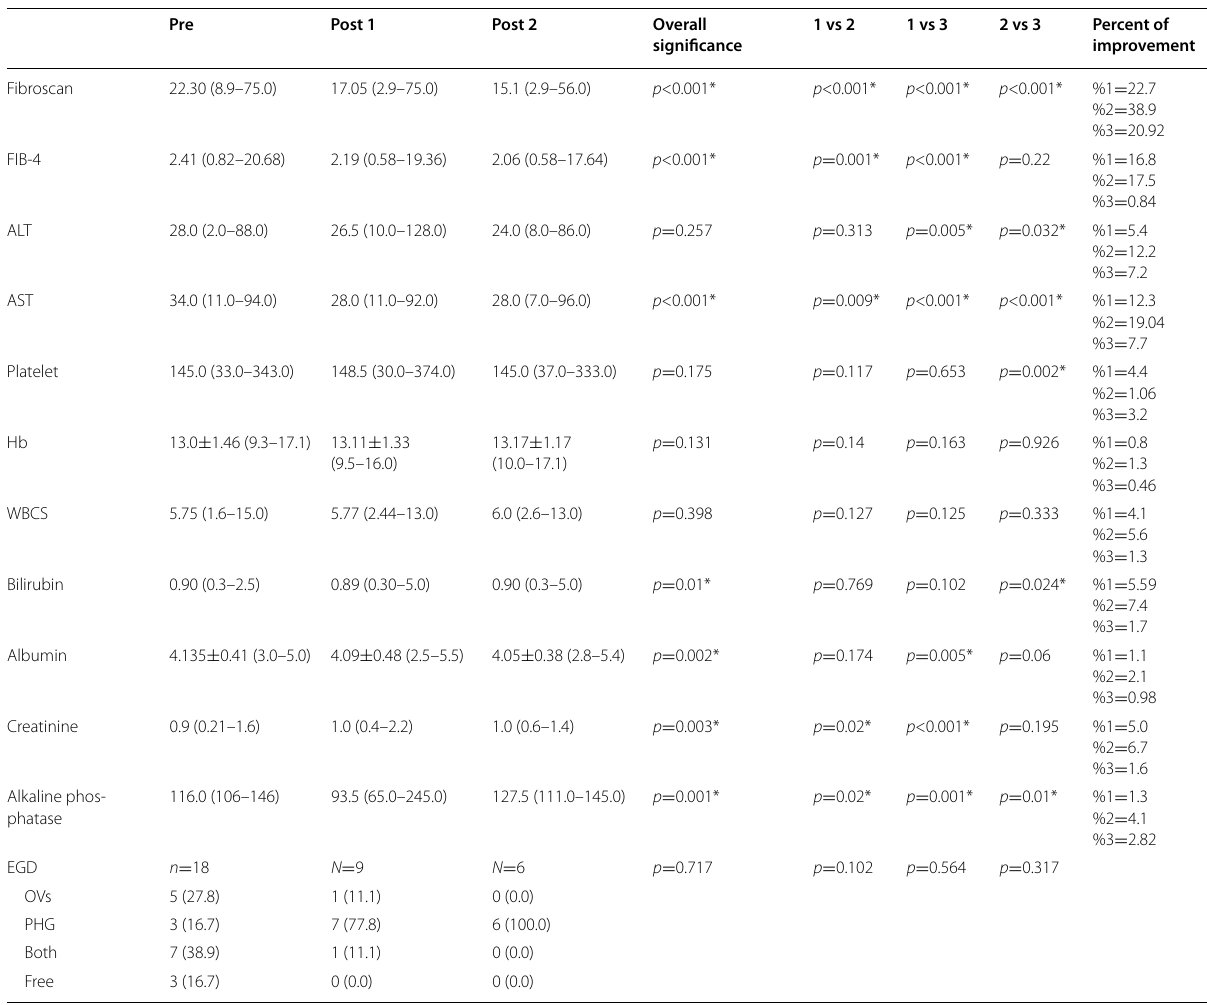
Table 2 Radiographic and laboratory results pre and post treatment among studied